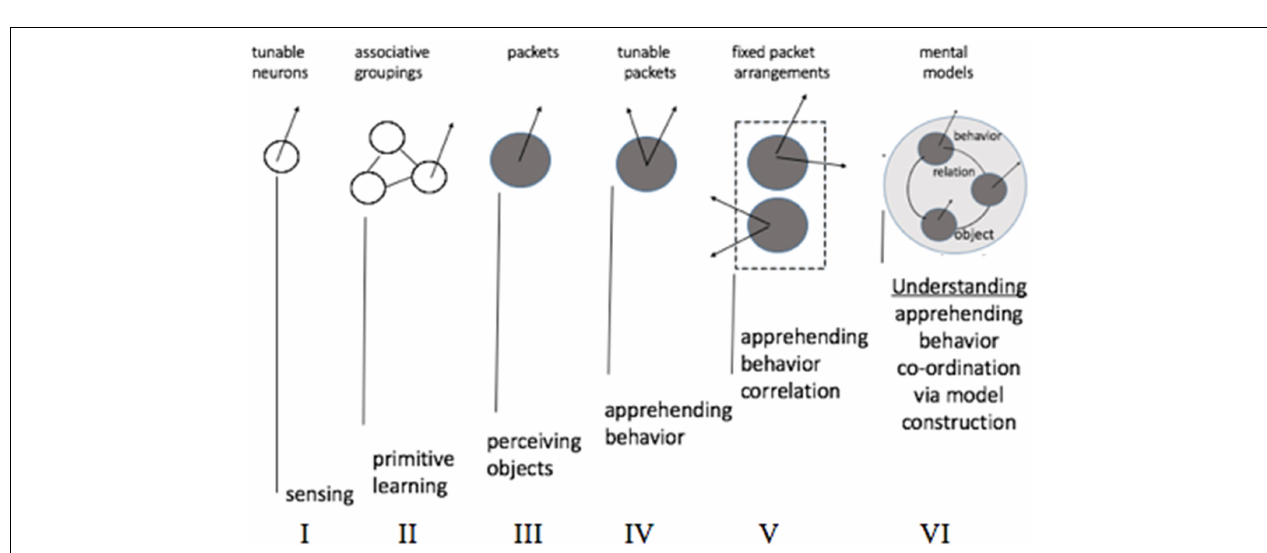
FIGURE 13 | Frogs shoot their tongues at small moving objects in sufficient proximity. (A) Mobilizing, firing and inhibiting neurons consumes energy and extracts energy deposits from the world stream (the flies). (B) Connections are formed between co-firing neurons and get strengthened with each successful episode (these connections can be genetically fixed, as in frogs). (C) Phase transition in the network turns the associative group into a cohesive packet bounded by an energy barrier. (D) The packet is a functional unit (has a receptive field computed as a function of receptive fields in the constituent neurons) amenable to mobilization and allocation. In the humans, mobilizing and allocating packets is experienced as perceiving “objects,” packet “tuning” (rotating packet vector) defines the states of the object, admissible transitions between the states define behaviors (self-directed packet manipulation is available to humans but not to frogs).